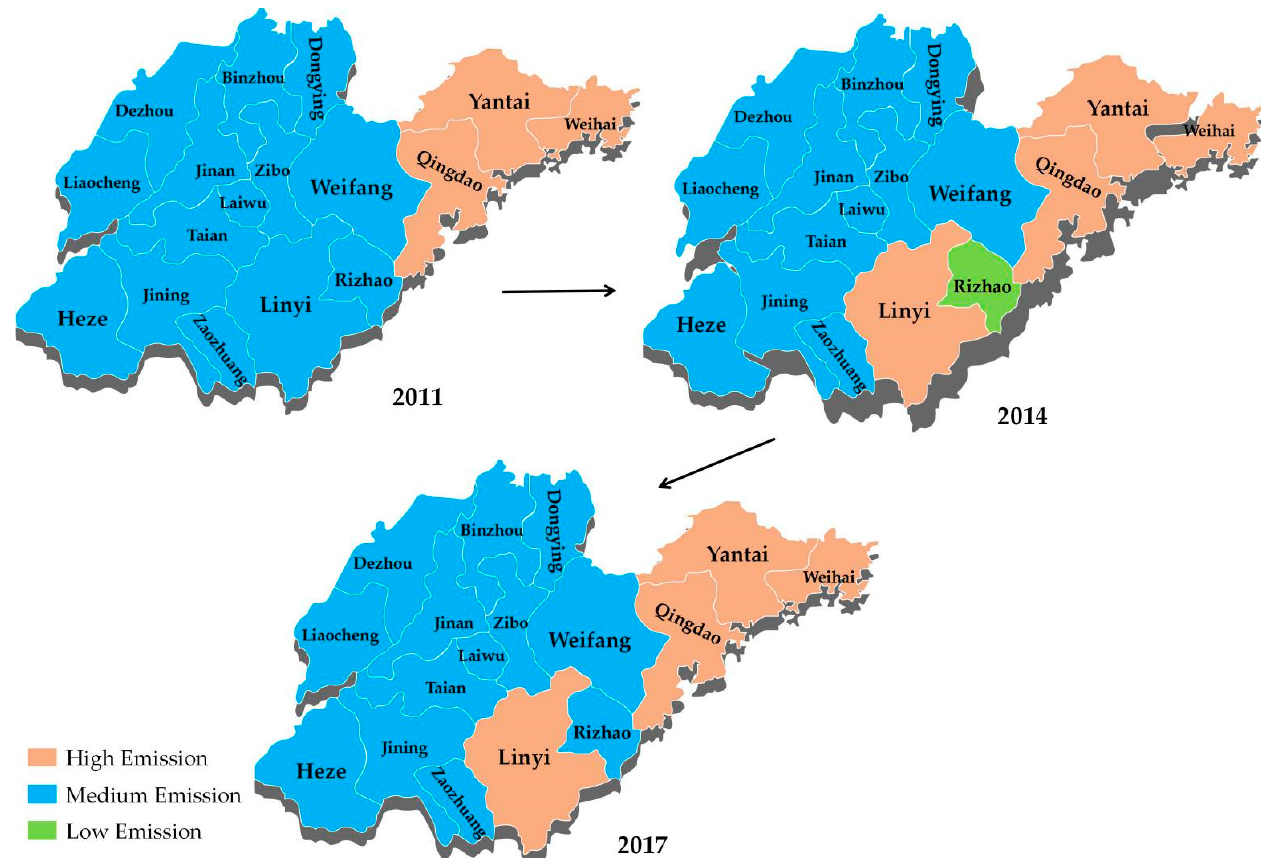
Figure 5. Spatio-temporal evolution map of carbon emissions in Shandong Province.